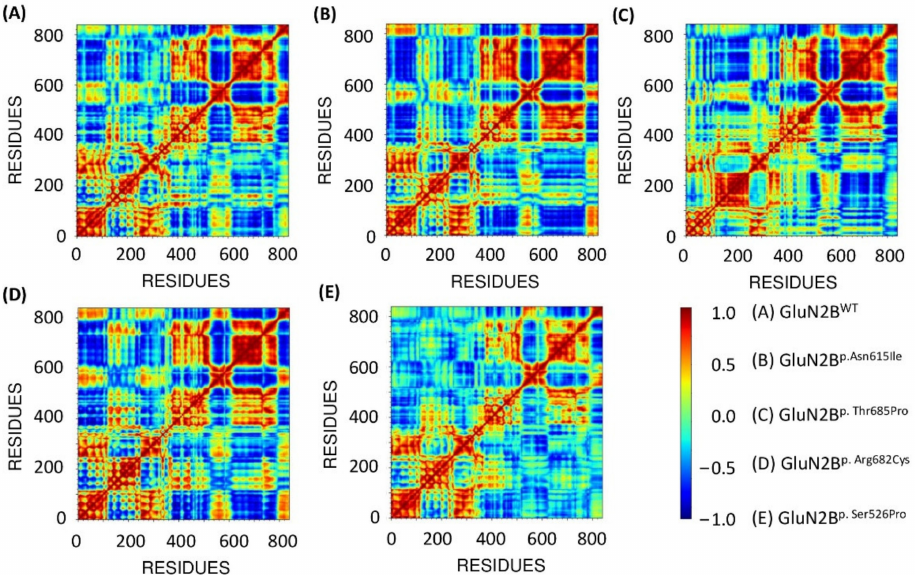
Figure 10. DCCM of the native protein GluN2B WT ( A ) and four variants GluN2B p.Asn615Ile ( B ), GluN2B p.Thr685Pro ( C ), GluN2B p.Arg682Cys ( D ), and GluN2B p.Ser526Pro ( E